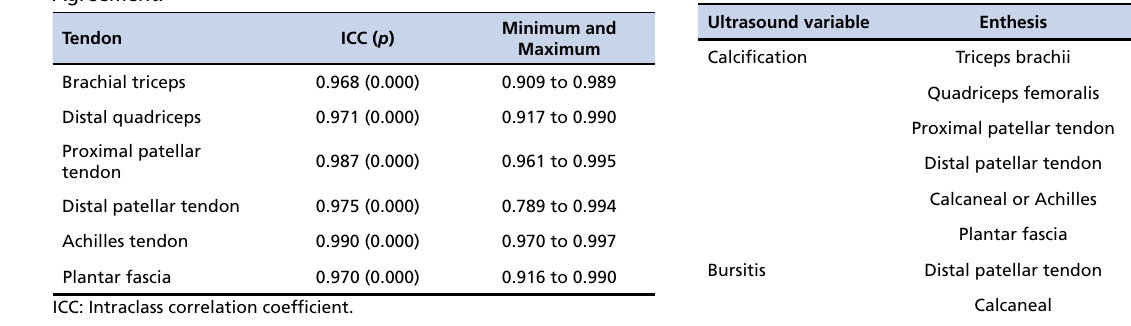
Table 5 - Cohen’s Kappa Correlation for Semiquantitative Measures in the Interobserver